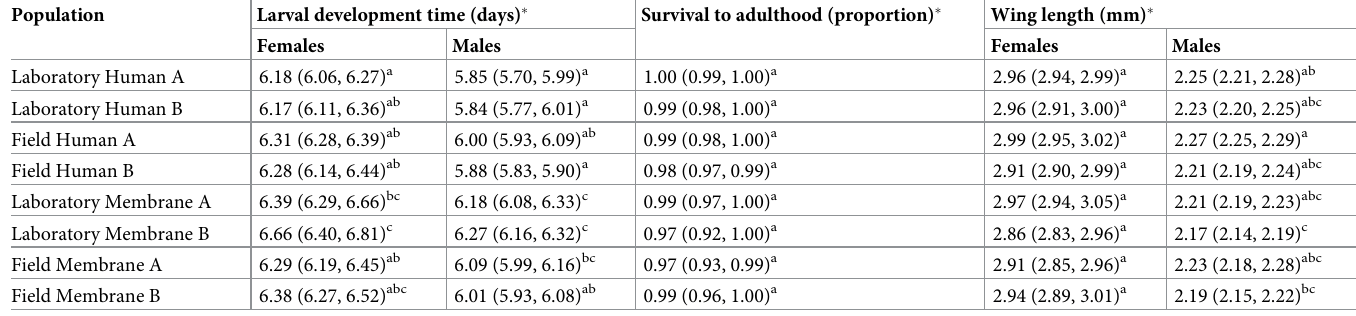
� Medians are shown followed by lower and upper 95% confidence intervals in parentheses. Within a column, different letters indicate significant (P < 0.05) differences between populations by Tukey’s post-hoc test with Bonferroni correction for the number of traits